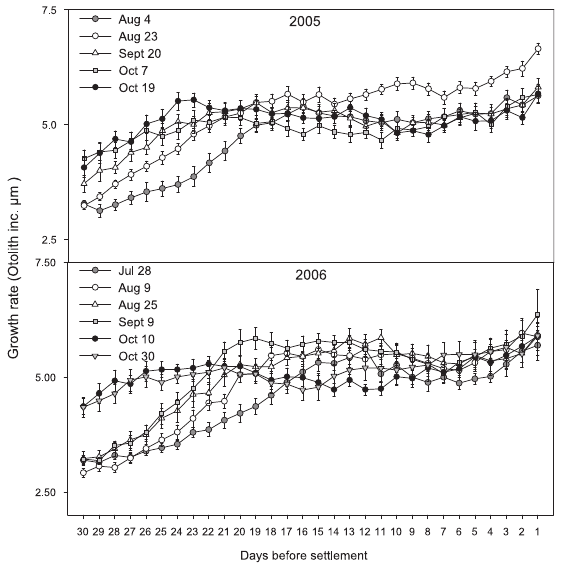
Fig. 4. – Average hindcast growth trajectories of Coris julis recruits sampled on each survey at Varadouro (Faial island). Mean values are shown ± SE for 2005 and 2006.